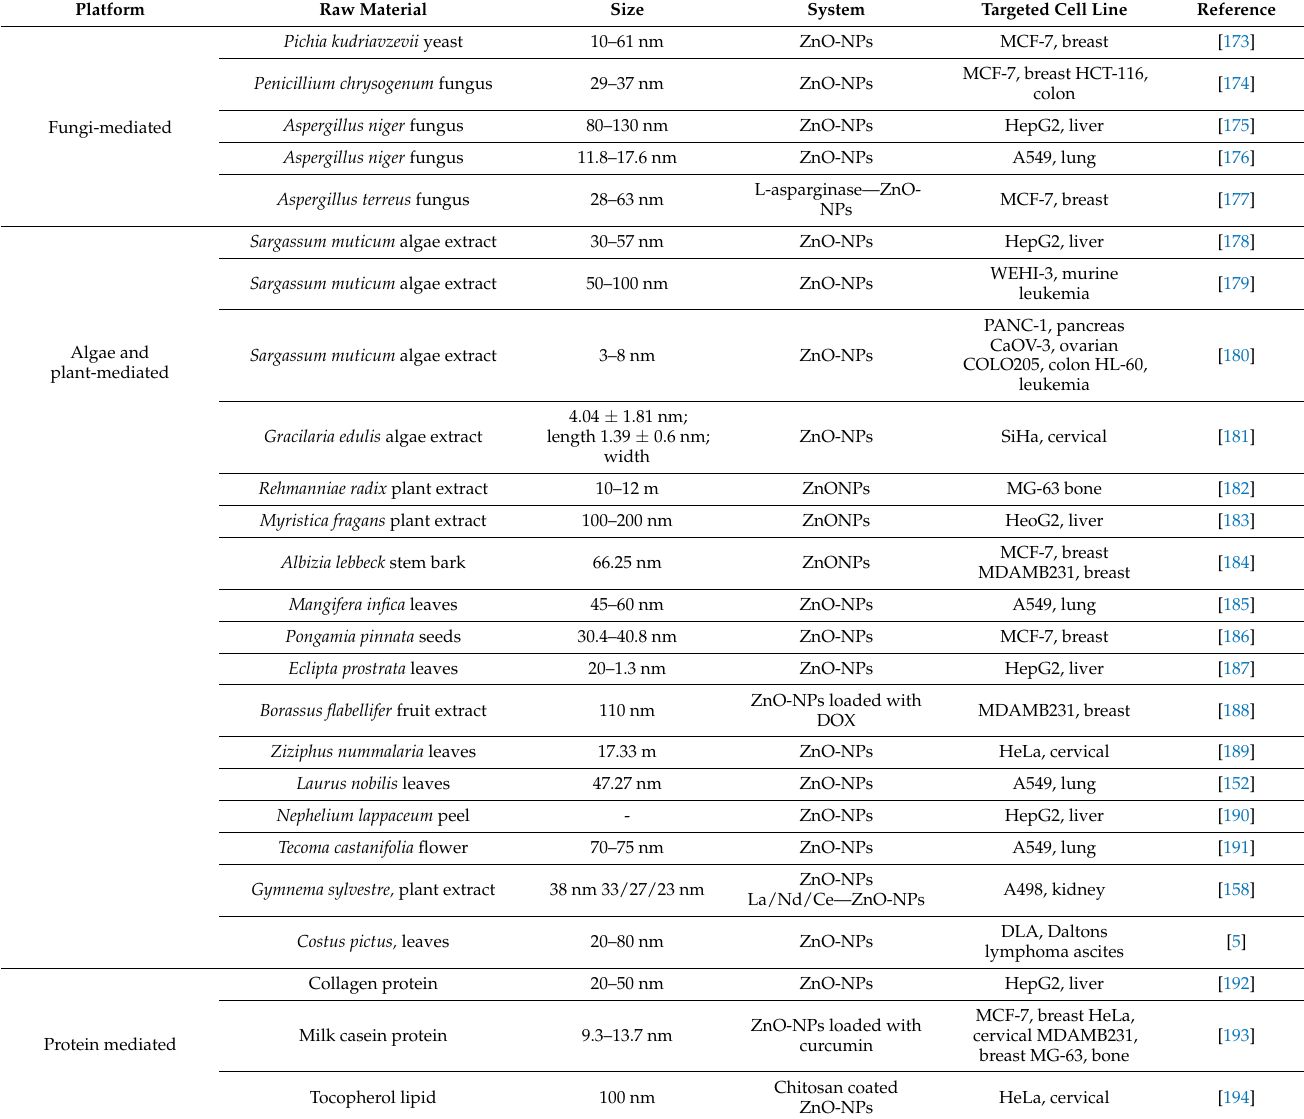
Table 7. Anticancer applications of ZnO-NPs generated in the green synthesis